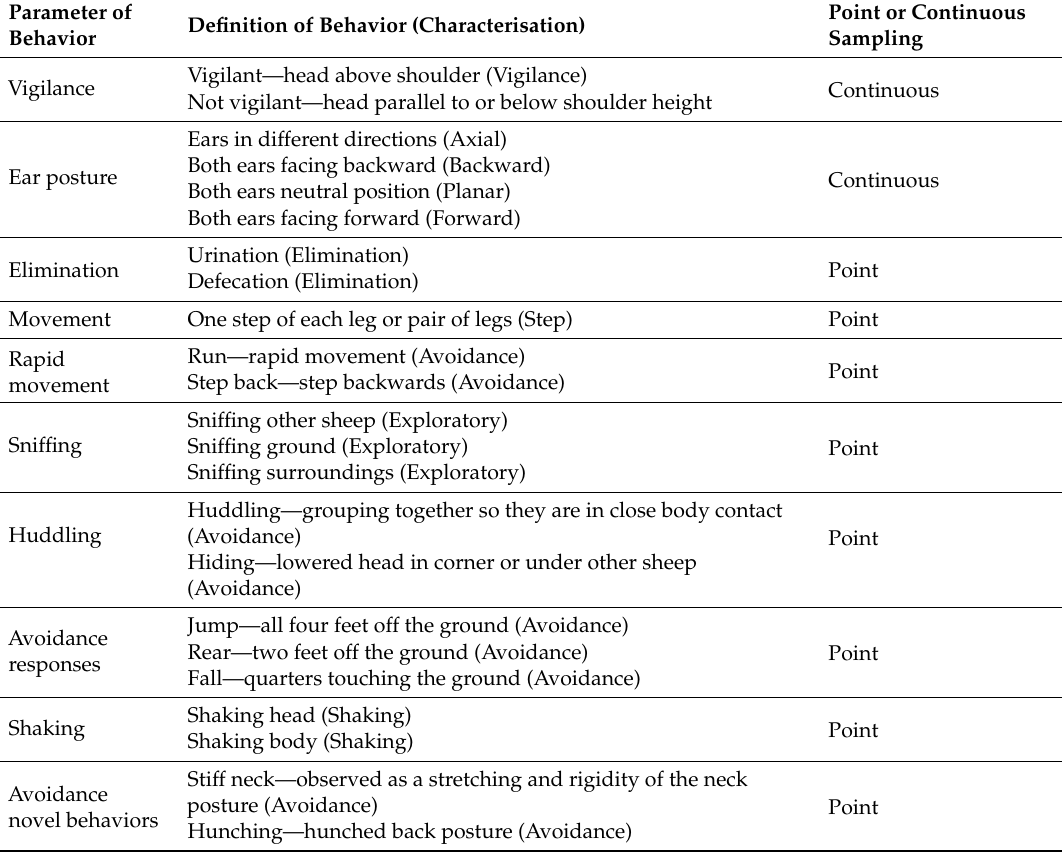
Table 1. Behavioral